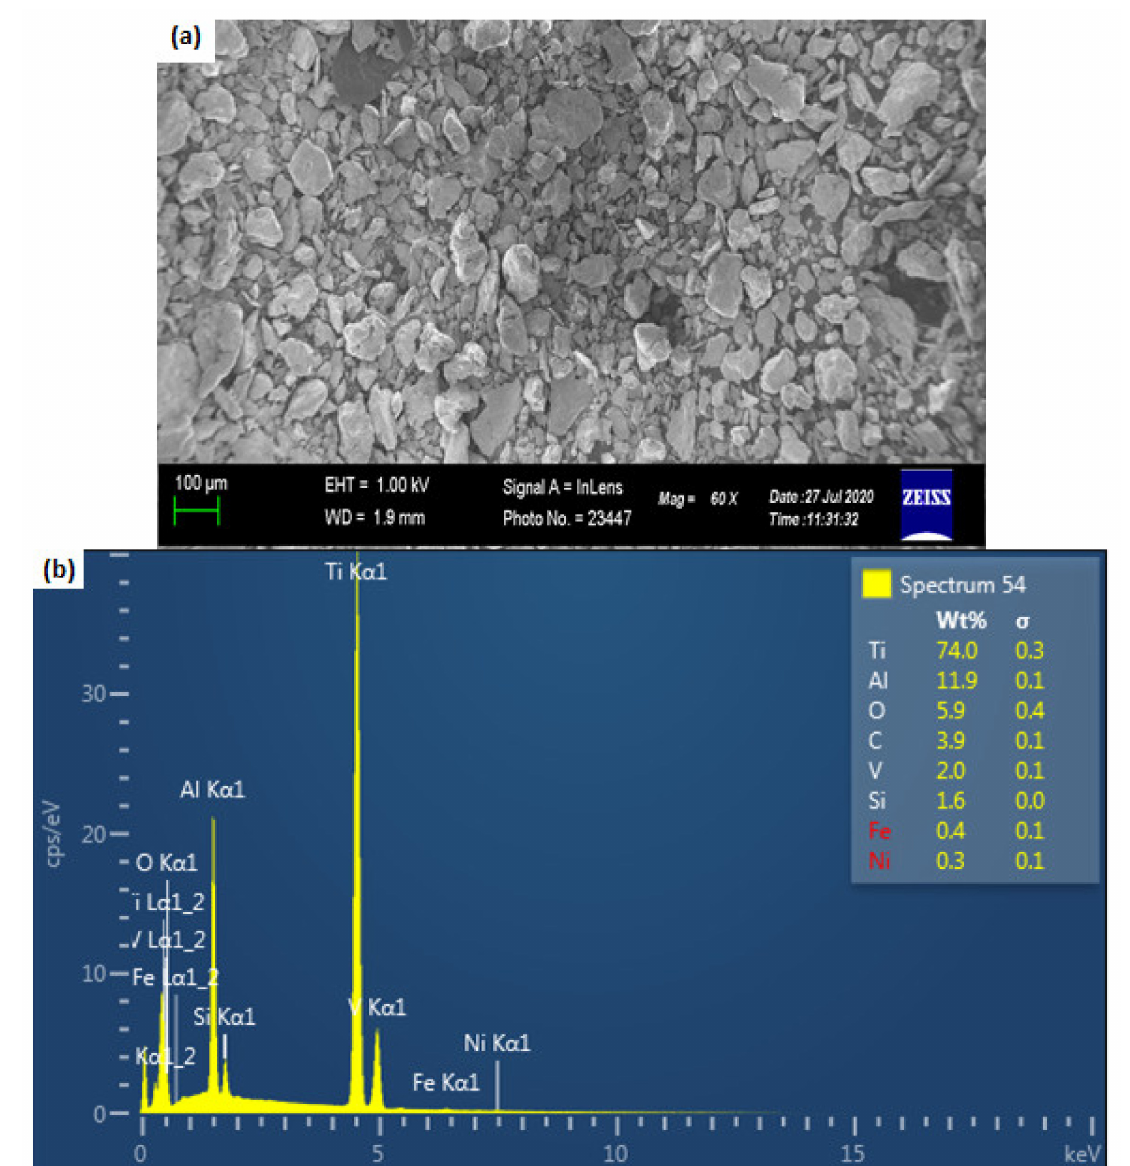
Figure 2. Scanning electron microscope (SEM) micrograph ( a ) and energy dispersive X-ray spectrometer (EDS) results ( b ) of the as-received powder from the Council for Scientific and Industrial Research